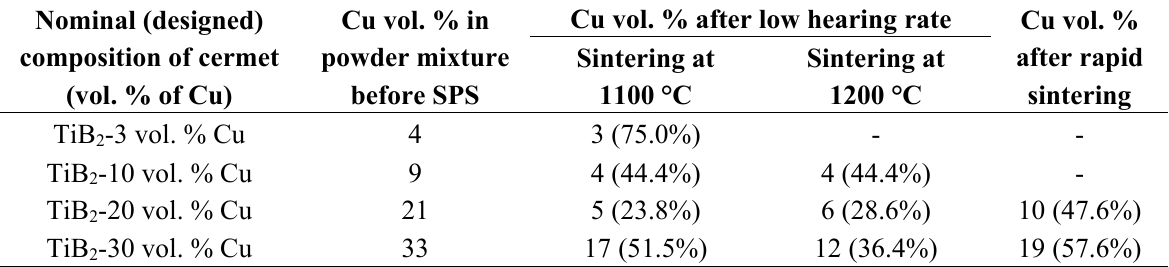
Table 1. Nominal and experimental values of Cu content in TiB 2 -Cu cermets after Spark Plasma Sintering (SPS). The numbers indicate volume fraction of Cu, while the value in parenthesis indicates the amount referred to initial content in powder mixture. Cu vol. % after low hearing rate Cu vol. % Nominal (designed) Cu vol. % in composition of cermet powder mixture after rapid Sintering at Sintering at (vol. % of Cu) before SPS sintering 1100 °C 1200 °C TiB -3 vol. % Cu 2 TiB -10 vol. % Cu 2 TiB -20 vol. % Cu 2 TiB -30 vol. % 2